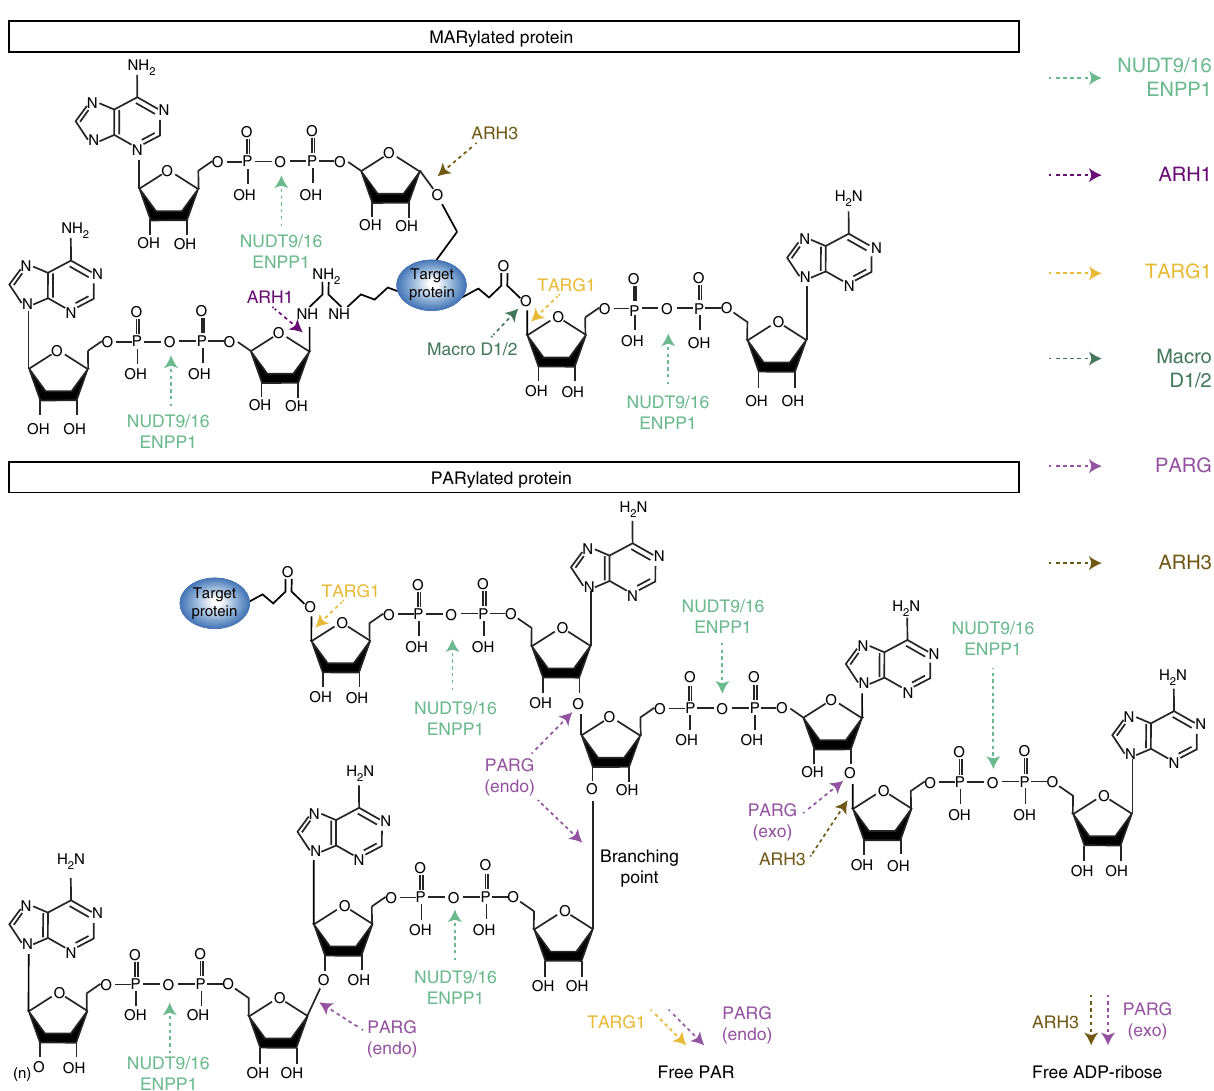
Fig. 3 Reversal of protein ADP-ribosylation by MAR and PAR erasers. The diagrams represent MARylated (upper panel) and PARylated proteins (lower panel) with bond-speci fi c chemical cleavage sites for each eraser. A subgroup of erasers that comprises MacroD1, MacroD2, and ARH1 are MAR-speci fi c erasers involved in the removal of single ADP-ribose adducts. MacroD1 and MacroD2 are macrodomain-containing enzymes that release ADP-ribose from ADP-ribosylated acidic residues (aspartate and glutamate). ARH1 is currently the only known MAR hydrolase that speci fi cally removes MAR from arginine residues. A second subgroup that includes TARG1, ARH3, NUDT9, NUDT16, and ENPP1 can target both MAR and PAR modi fi cations. The TARG1 macroprotein hydrolyzes glutamate-ADP-ribose bonds and releases ADP-ribose from MARylated proteins. TARG1 has also the unique ability to remove entire PAR chains from acidic residues of PARylated proteins. ARH3 is limited to exoglycosidic activity toward PAR chains and releases free ADP-ribose. In addition, it possesses MAR hydrolase activity speci fi cally targeting the O-linked ADP-ribosylation. NUDT9 and NUDT16 have nucleoside diphosphate- linked moiety-X (NUDIX) domains, which cleave pyrophosphate bonds and release phospho-ribosyl-AMP from PAR chains or AMP from MARylated proteins as major reaction products. ENPP1 is a pyrophosphatase lacking a NUDIX domain but with the capability of digesting PAR and MAR modi fi cations similar to NUDIX enzymes. PARG is the main PAR-degrading enzyme but shows no activity towards MARylated proteins. Human PARG is unable to cleave the proximal ADP-ribose groups from a modi fi ed protein but possesses exo- and endoglycosidic activities to hydrolyze the glycosidic bonds between ribose units of PAR. The exoglycosidic activity of PARG generates free ADP-ribose from the processive degradation of PAR from the distal to the proximal end while its in-chain cleavage activity (endoglycosidic) produces protein-free PAR. The endoglycosidic degradation of PAR by of PARG is also responsible for the hydrolysis of the branching points formed when non-adenine riboses are linked together (branching